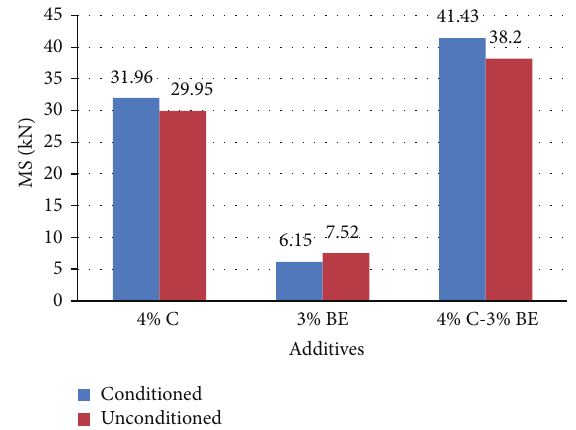
Figure 6: MS values of conditioned and unconditioned specimens.